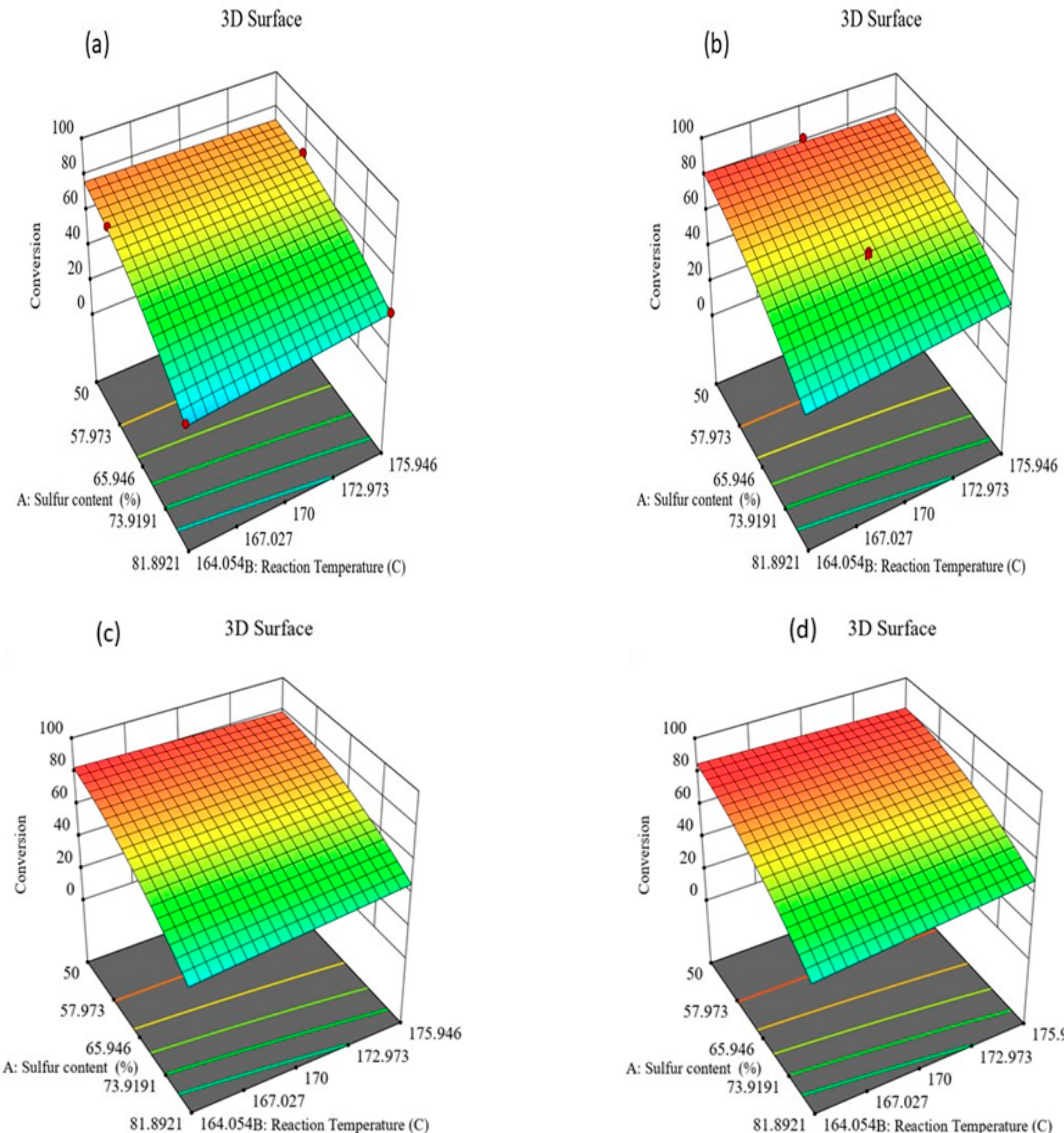
Figure 3. Influence of reaction conditions on sulfur conversion at different times ( a ) 42 min, ( b ) 60 min, ( c ) 65 min, and ( d ) 74.21 min.